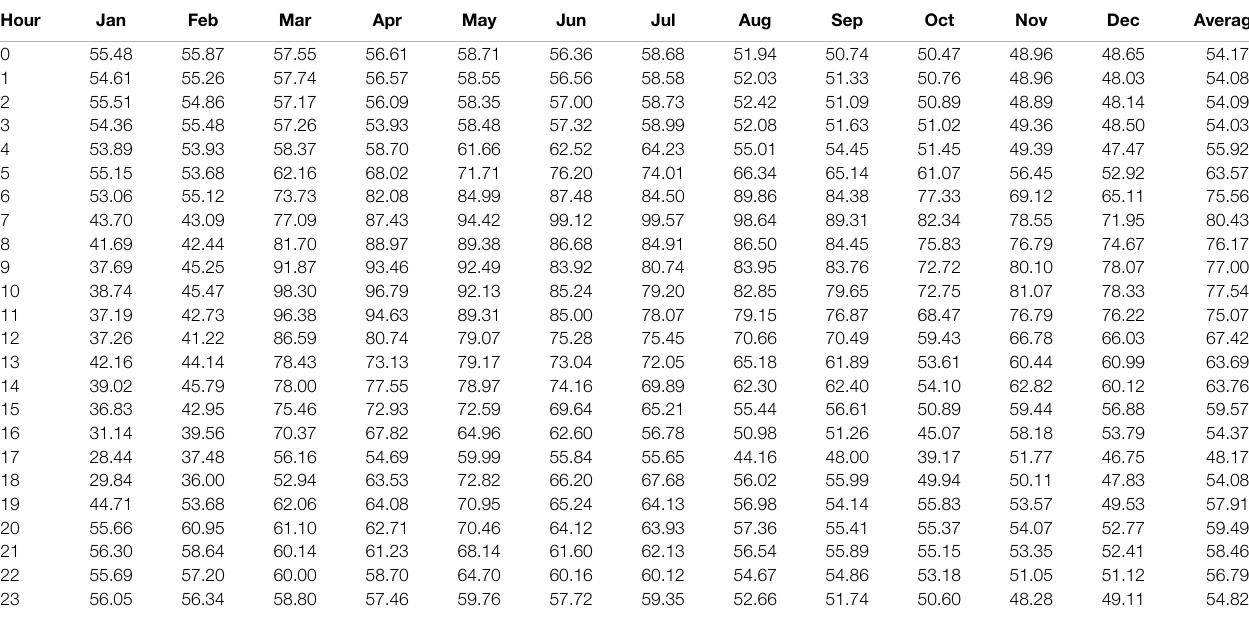
TABLE 2 | Calculated average demand (kW) for the university working days of the year